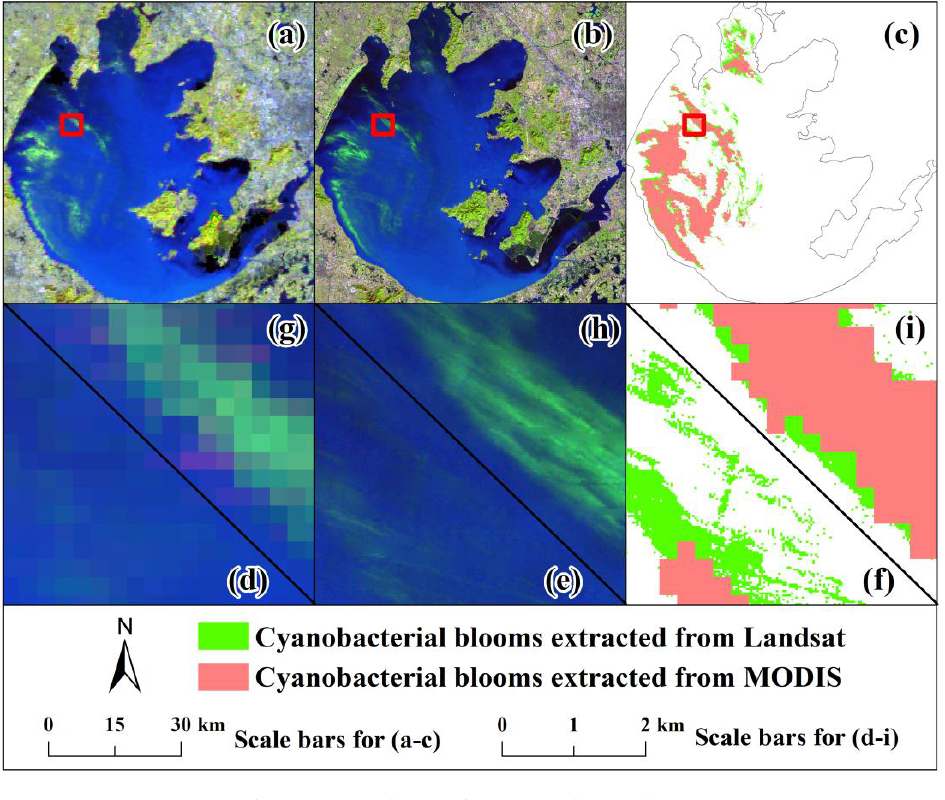
Figure 13. Comparison between Landsat and MODIS data. ( a ) MODIS imagery on 05 December 2014, R : G : B = band sur_refl_b05:sur_refl_b02:sur_refl_b01. ( b ) Landsat imagery on 05 December 2014, R : G : B = band 7 : 5 : 4. ( c ) Cyanobacterial blooms extracted from Landsat and MODIS imagery. ( d – i ) Enlargement of the small areas marked by red boxes in ( a ), ( b ), and ( c ).